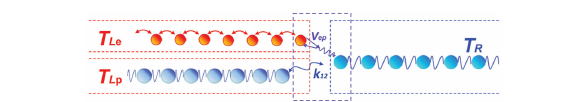
FIGURE 10 | The lattice model of the metal–insulator interface, adapted with permission from the copyright holder (Institute of Physics), Zhang et al. (2013a).